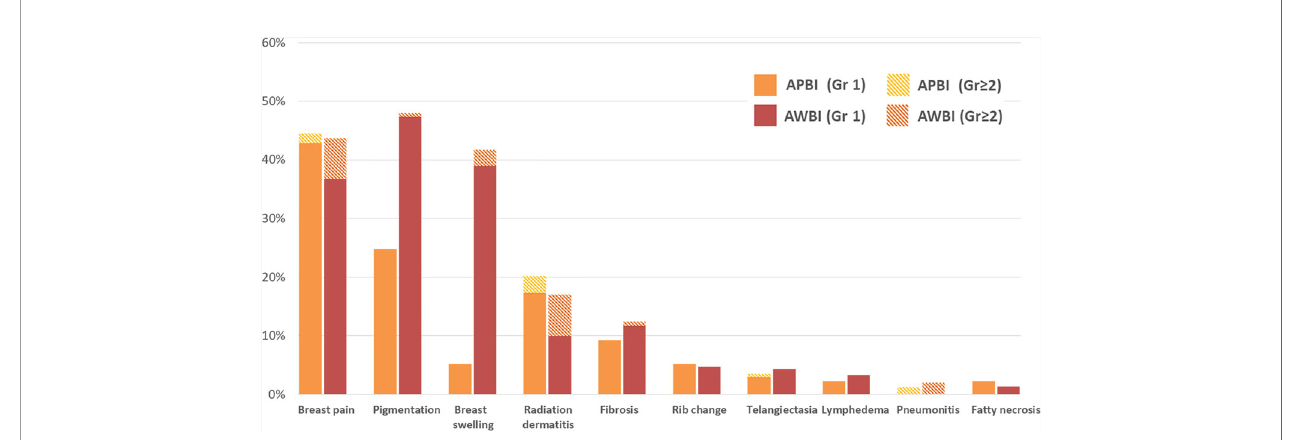
FIGURE 3 | Late toxicities (at least 6 months after radiotherapy) by treatment group.